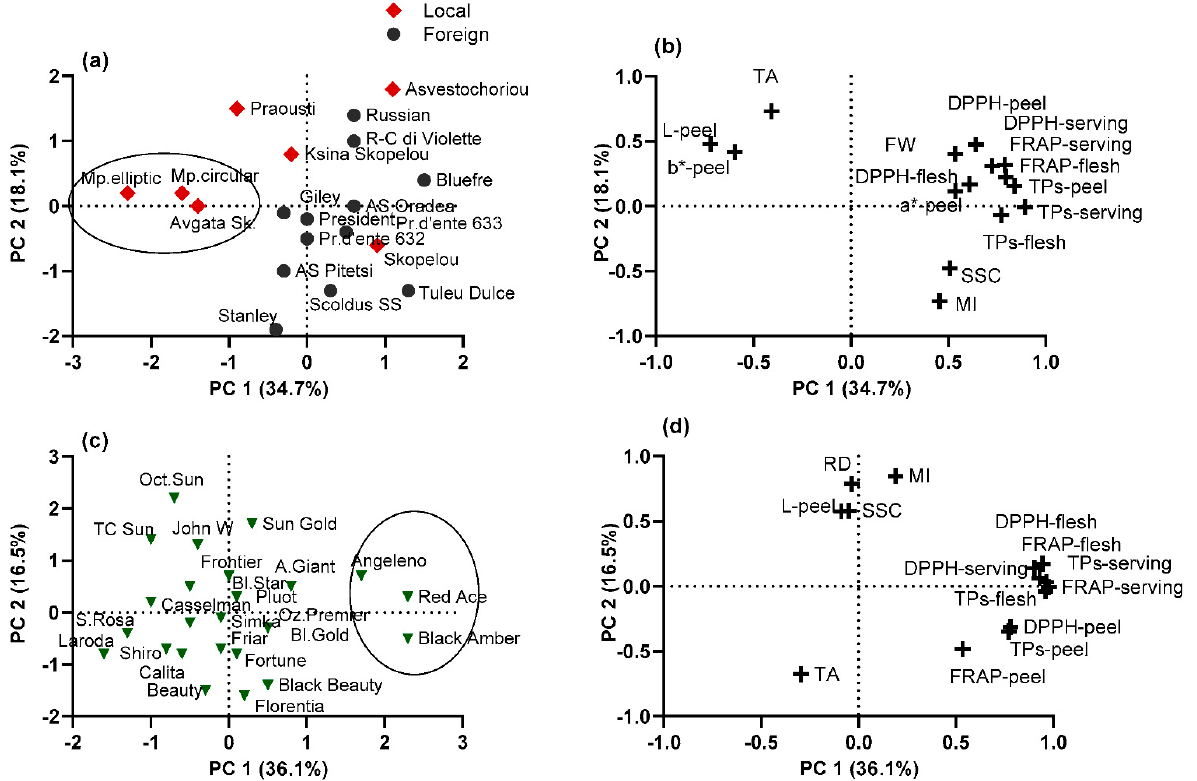
Figure 4. ( a , c ) Segregation and ( b , d ) factor loadings, of ( a , b ) 19 European and ( c , d ) 24 Japanese plum cultivars, on the basis of fruit physical and chemical characters, determined by principal component analysis. Variable annotations are presented in Table